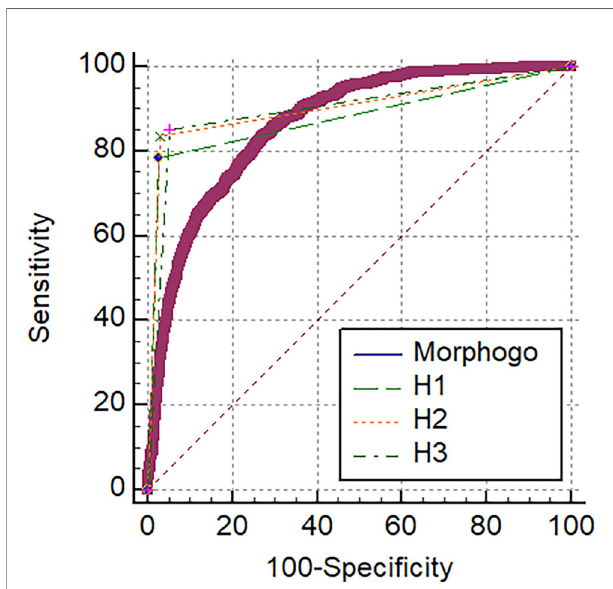
FIGURE 2 | The correlation of ROC curve between Morphogo and pathologists.